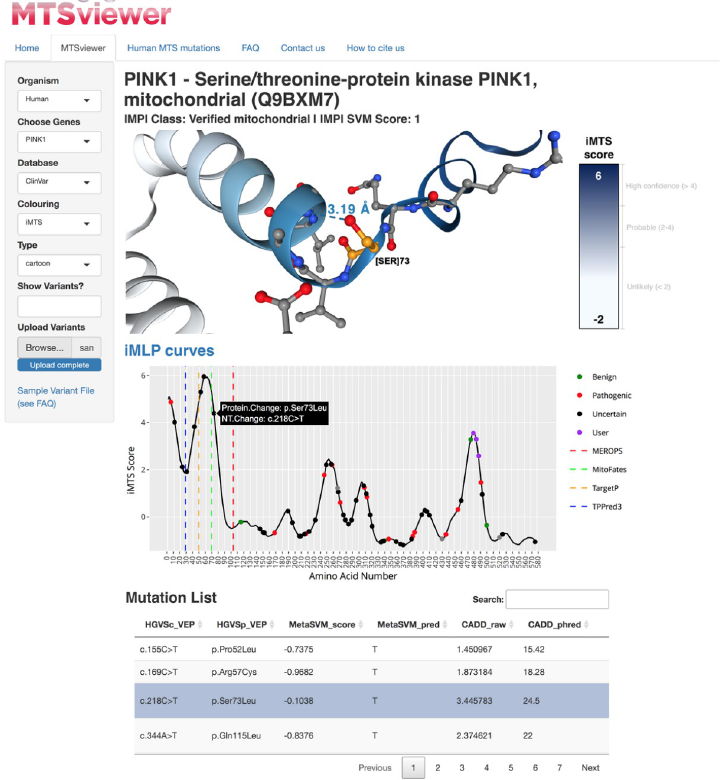
Fig 2. MTSviewer output for PINK1. A sample output from MTSviewer investigating human PINK1, a mitochondrial kinase with a uniquely long MTS and multiple predicted cleavage sites. Protein sequence, prediction algorithms, and N-terminomics data tables have been omitted for clarity but are available in full on the interactive MTSviewer web server. Ser73Leu has been highlighted as a variant of interest, as Ser73 is found within a region of high MTS propensity near the predicted MitoFates cleavage